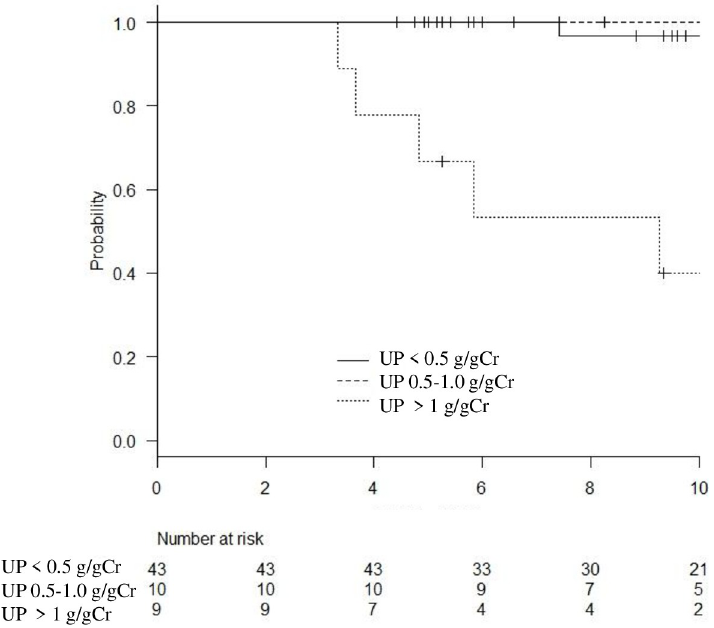
Fig 3. Renal survival probability, defined by less than 30% eGFR decline from diagnosis, as determined by Kaplan–Meier analysis.